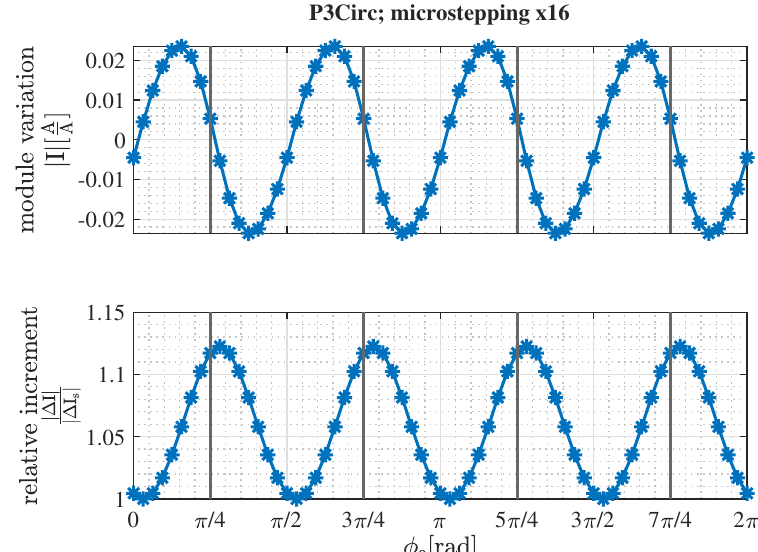
Figure 7. Torque variation and increment relative to a sine-cosine microstepping of equal resolution; p = 3, microstepping resolution x16.